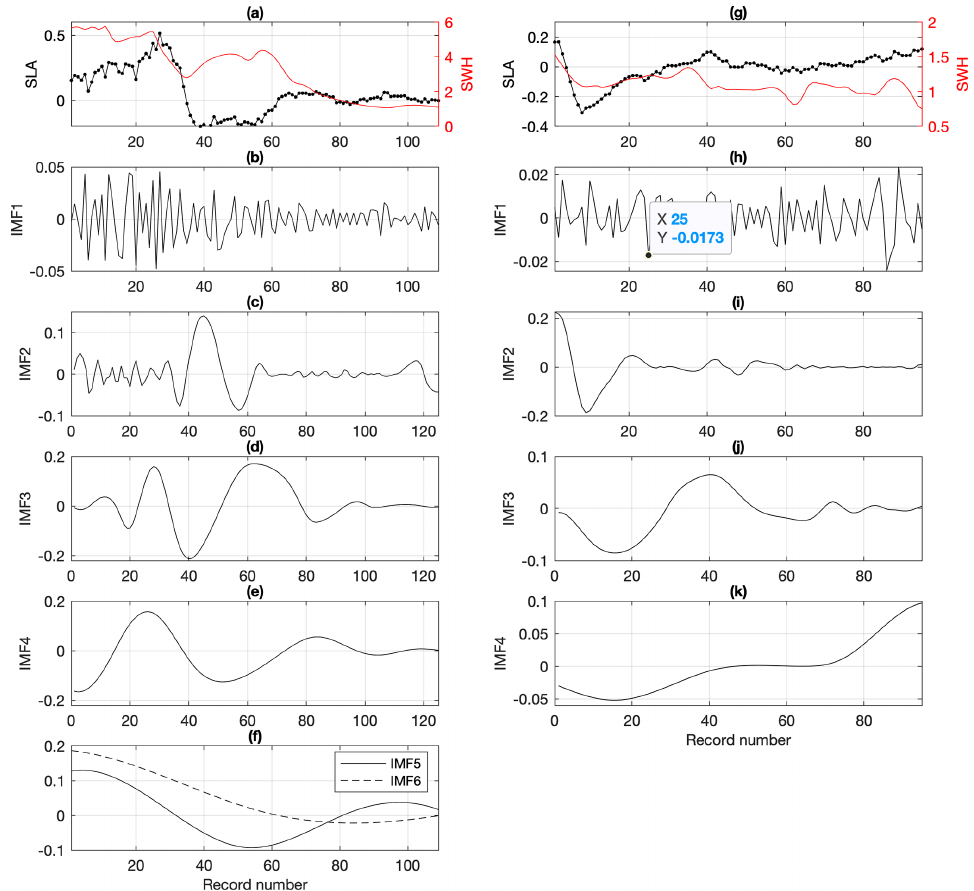
Figure 1. SARAL SLAs ( a and g ) in the Gulf Stream area for cycle 106 and passes 53 (a–f) and 597 (g–k) , and the corresponding IMFs obtained from the EMD decomposition ( b – f and h – k ). SWH associated with the SLA is shown in red curves ( a and g ). All units in meters.